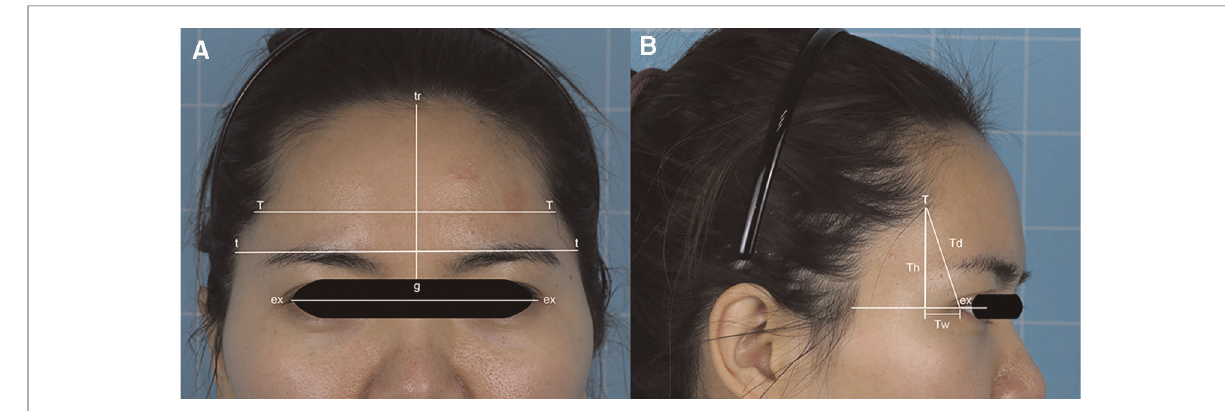
FIGURE 3 Measurements of the temporal hairline. ex-ex, intercanthal (ex- ex); Td, temporal peak depth; Th, temporal peak height; tr-g, forehead height; t-t, forehead width; T-T, minimal forehead width; Tw, temporal peak